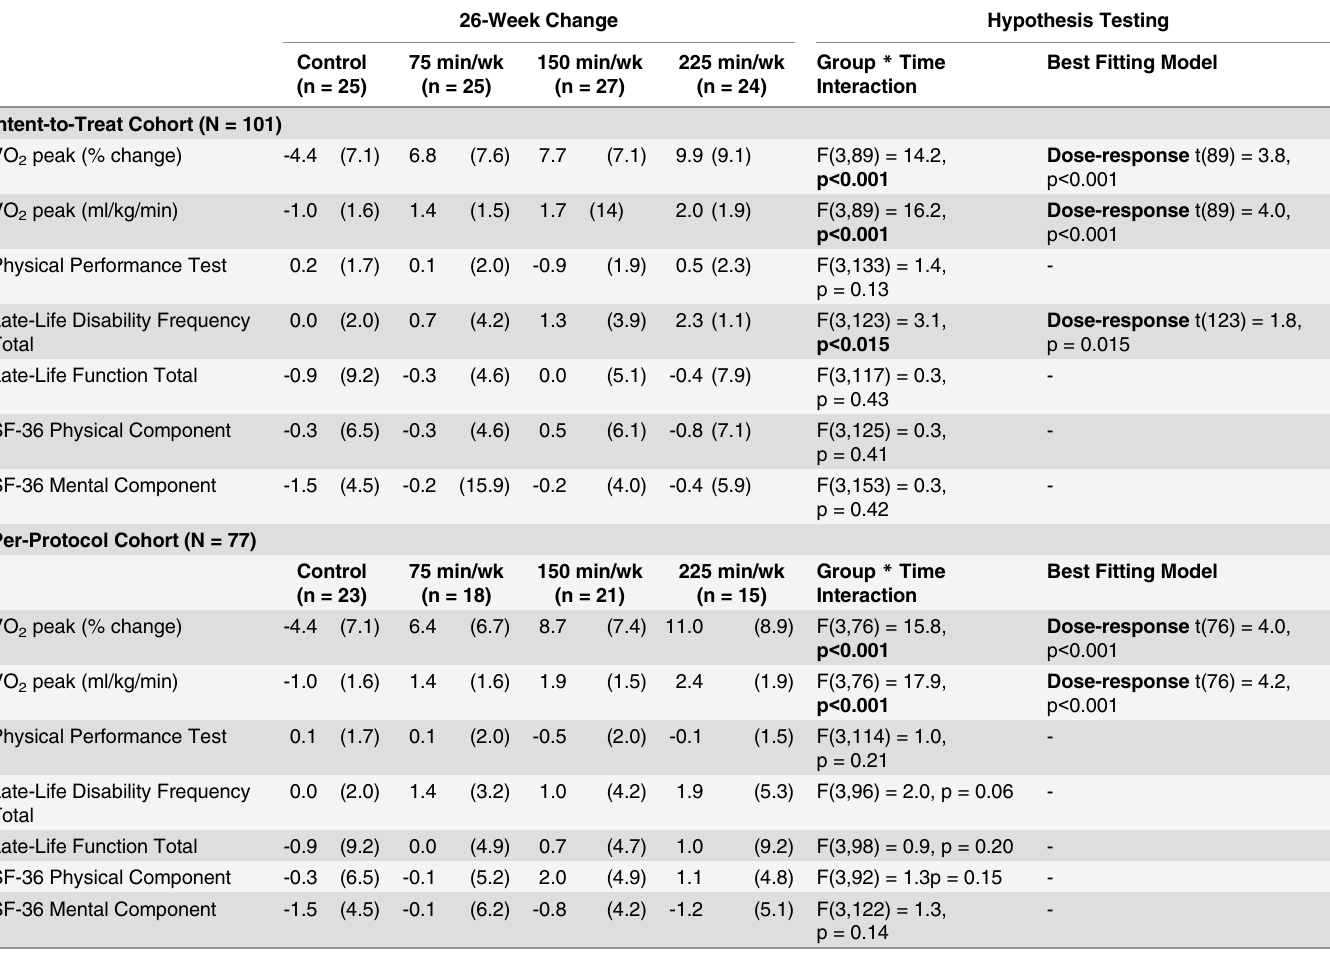
Table 2. Mean fitness and physical function change from baseline in both the intent-to-treat and per protocol